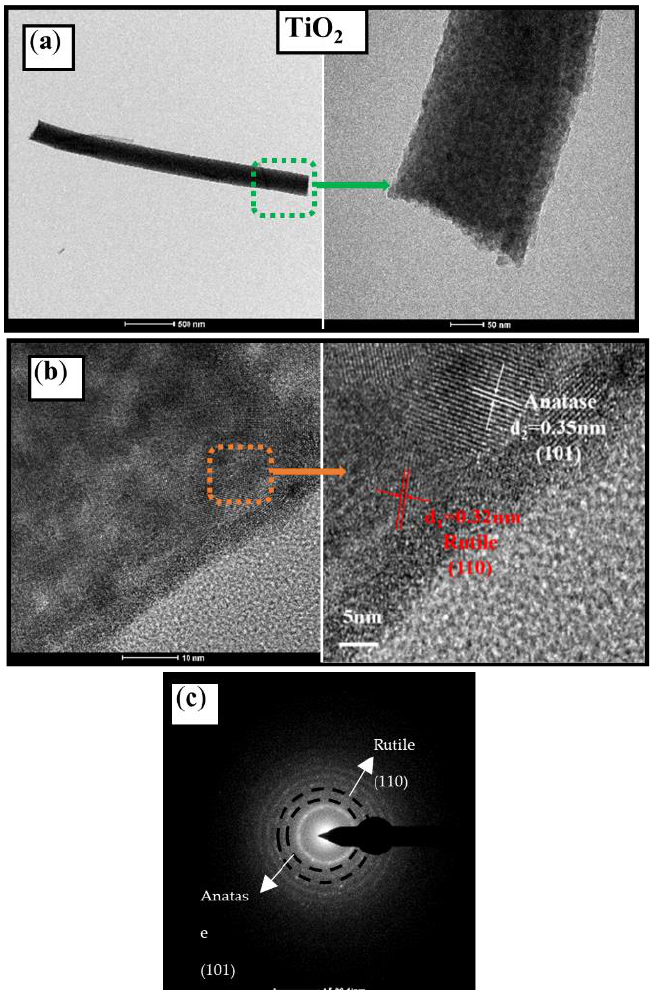
TiO 2 is flat, smooth, and compact, and there is no impurity attachment. For pure TiO 2 samples, HRTEM (Figure 3b) and diffraction pattern (Figure 3c) was used to measure and analyze. It is found that the prepared TiO 2 fiber exhibits a polycrystalline state after calcination at 700 ◦ C, and the lattice spacing indicates that this polycrystalline state consists of anatase phase (0.35 nm) and rutile phase (0.32 nm). This is due to the different cooling rates at different locations of the fibers after calcination. It is further found that the two- phase structures are adjacent to each other and easy to form heterojunction structures, which may have a positive effect on photocatalytic behavior.